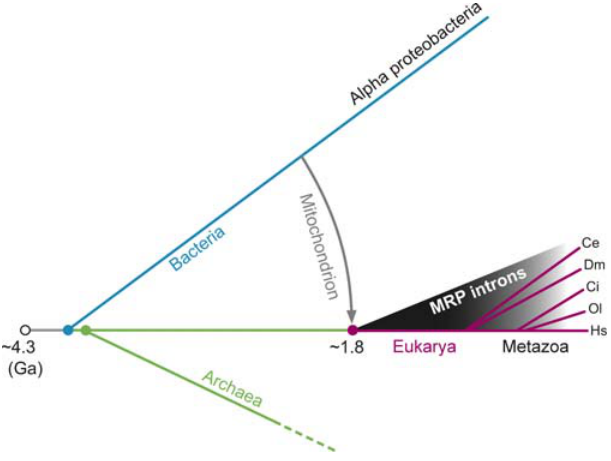
Figure 4. Predicted Time of Appearance of MRP Introns MRP genes were predicted to be intronless at the time of endosymbiosis (arrow) and all of their spliceosomal introns were gained after their transposition to the nuclear genome. The time scale is based on data from Hedges [31] and Battistuzzi et al. [32]. Ce, Ca. elegans; Ci, Ci. intestinalis; Dm, Dr. melanogaster; Ga, billion years ago; Hs, H. sapiens; Ol, O. laptides